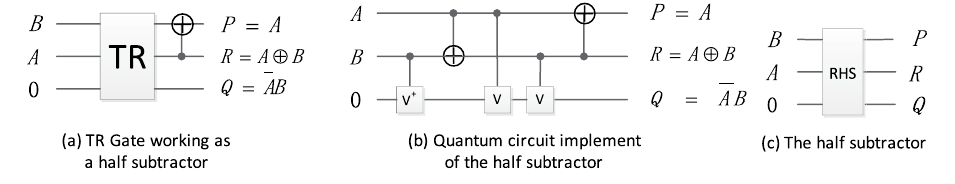
Figure 15. The RHS and its quantum circuit.